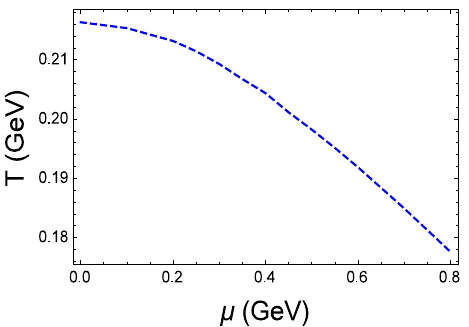
Figure 3. The decon(cid:12)nement phase transition line in the ( T; (cid:22) ) plane in the quenched dynamical holographic QCD